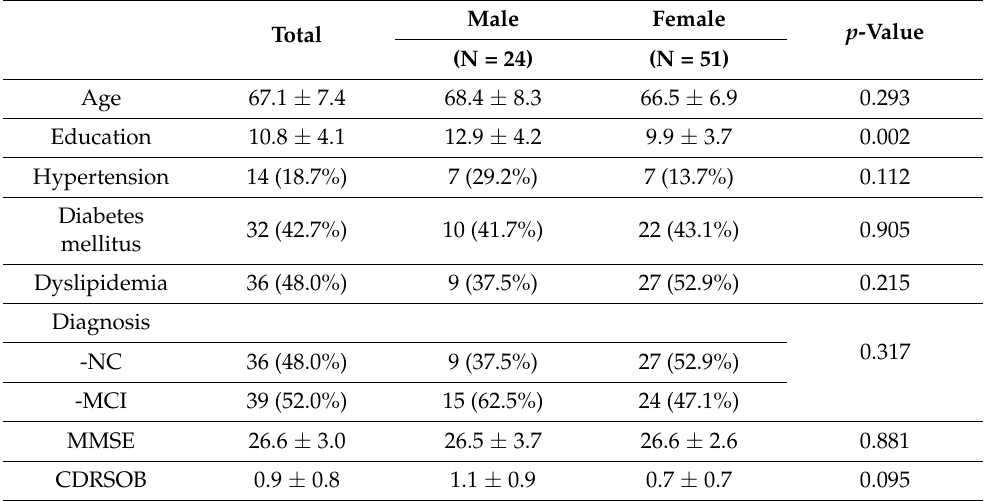
Table 1. Demographic characteristics of the participants and differences according to the sex.